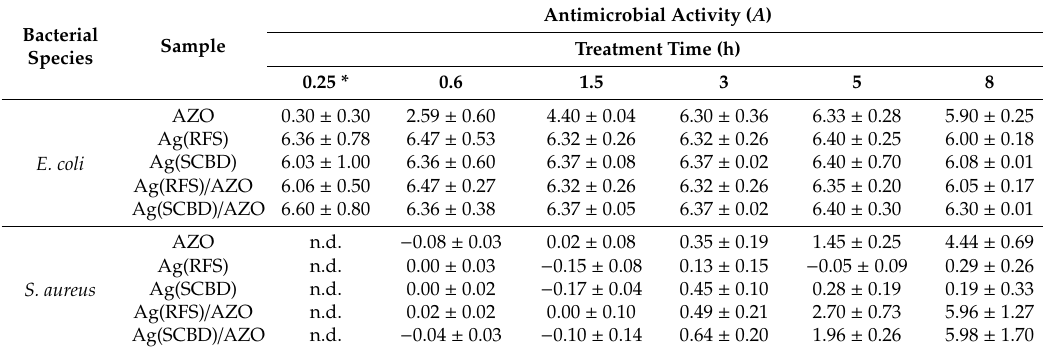
Table 3. Antimicrobial activity A against E. coli and S. aureus , calculated by Equation (1) at di ff erent times for samples deposited on PLA. Data are reported as the mean ± standard